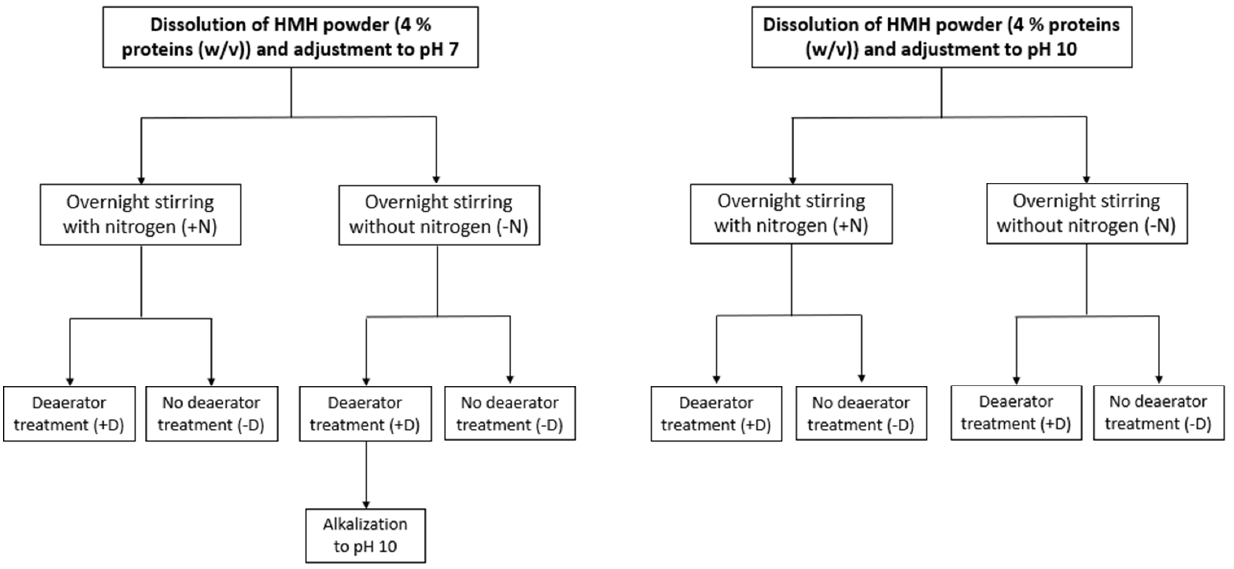
Figure 1. Summary of the eleven treatments performed on herring milt hydrolysate (HMH).